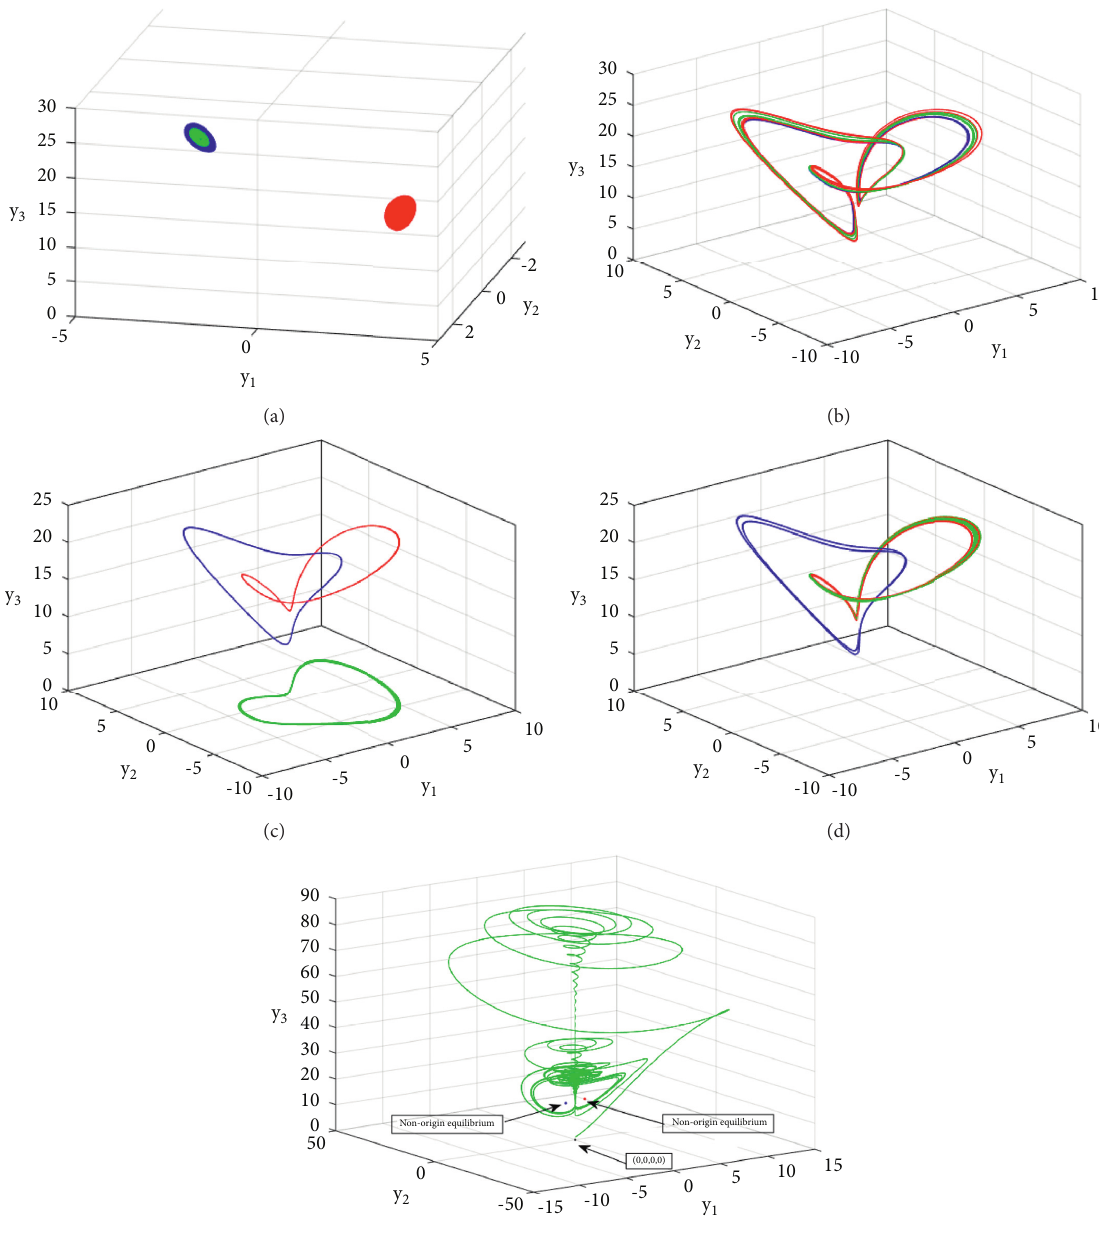
Figure 9: 3D view of multihidden attractors in the fractional-order Matouk’s system, with the fractional parameter α � 0 . 77 and initial conditions ( 0 . 1 , 0 , 1 , 0 . 01 ) for green trajectory, ( 3 , 1 , 15 , 0 . 0199 ) for red trajectory, and (− 3 , − 1 , 15 , 0 . 0199 ) for blue trajectory, showing the following: (a) coexisting unstable saddle-focus attractors for a � − 3 , b � 15 ,c � 0 . 8 ,d � − 0 . 0001 ,h � − 1 . 5 ; (b) coexisting homoclinic